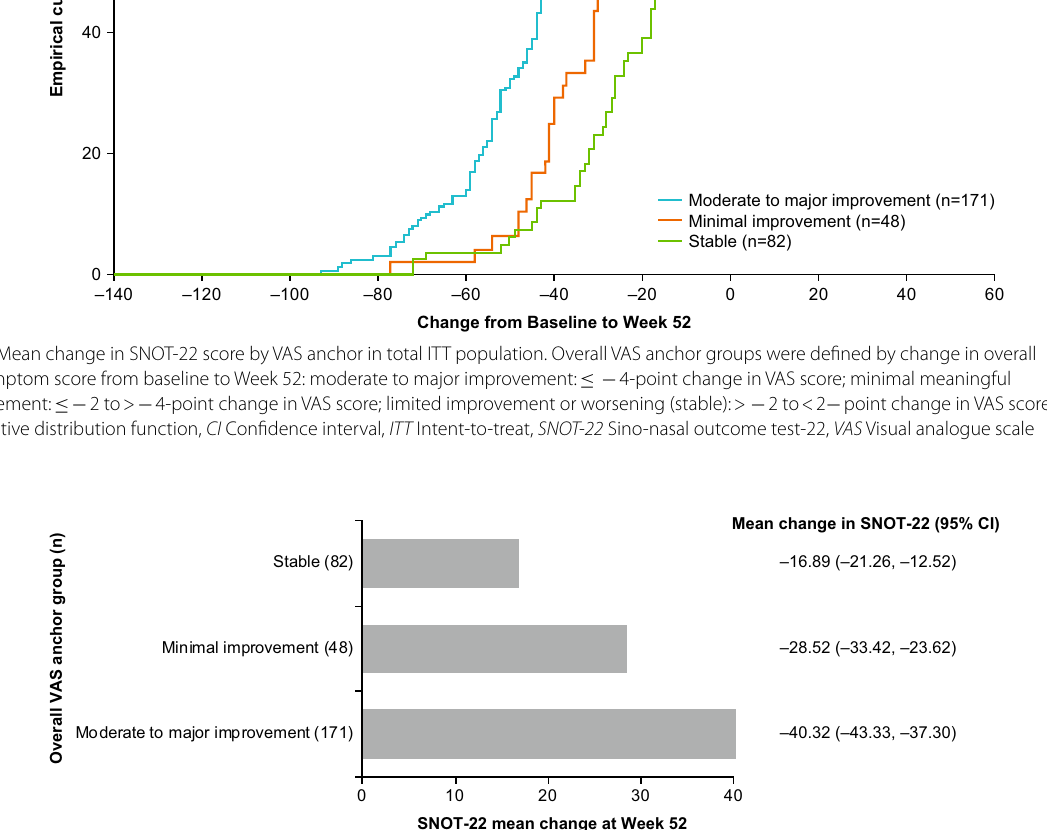
4-point change in VAS score; minimal meaningful ≤ − 2 to < 2-point change in VAS score. CDF −